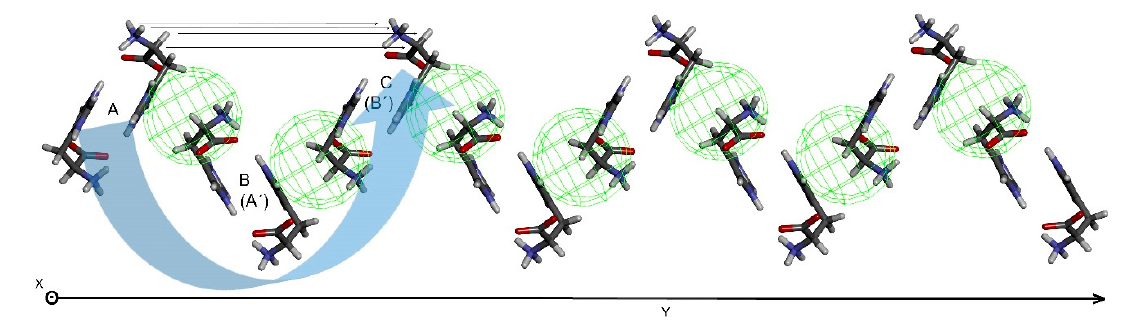
Figure 9. 2D-sheet generated by multiplication of a chosen pair of chains. The chains are viewed end-on. Green spheres indicate d(H3···H8’) = 2.90 Å through the sheet.